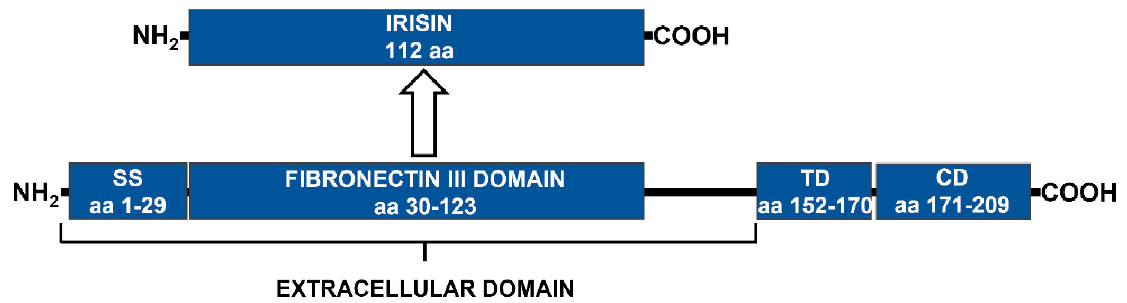
Figure 1. FNDC5/Irisin structure. Schematic structure of FNDC5. CD: Cytosolic Domain; FNDC5: Fibronectin type III Domain Containing 5; SS: Signal Sequence; TD: Transmembrane Domain.